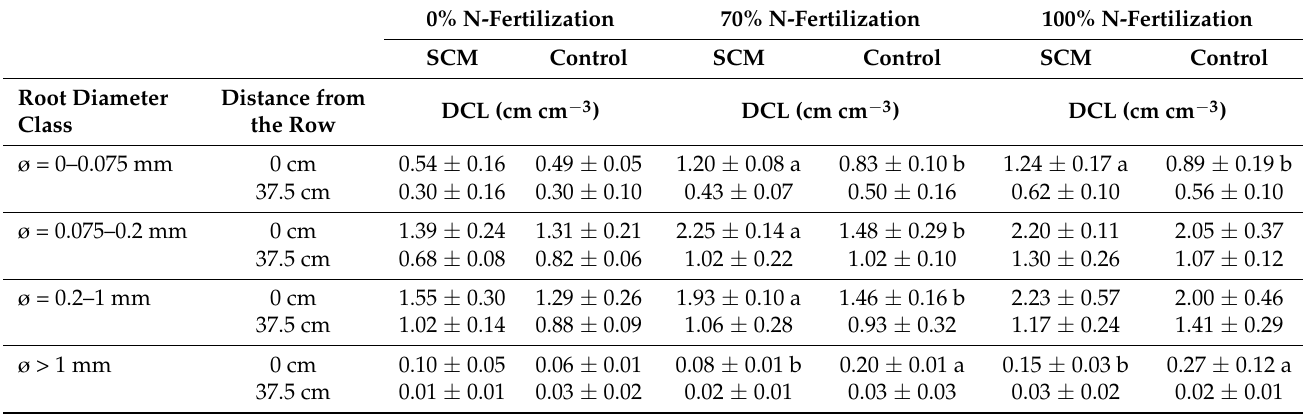
Table 3. Diameter class length (DCL) for very fine (ø = 0–0.075 mm), fine (ø = 0.075–0.2 mm), medium (ø = 0.2–1 mm) and coarse (ø > 1 mm) root diameters as affected by the interaction between presence/absence of SCM (SCM vs Control) and N-fertilization rate (0%, 70%, and 100% N-fertilization). Letters indicate differences SCM vs Control as obtained by the Tukey’s test performed for each level of N-fertilization rate (0%, 70%, and 100% N-fertilization) and distance from the row (0 cm, 35 cm); blank is not